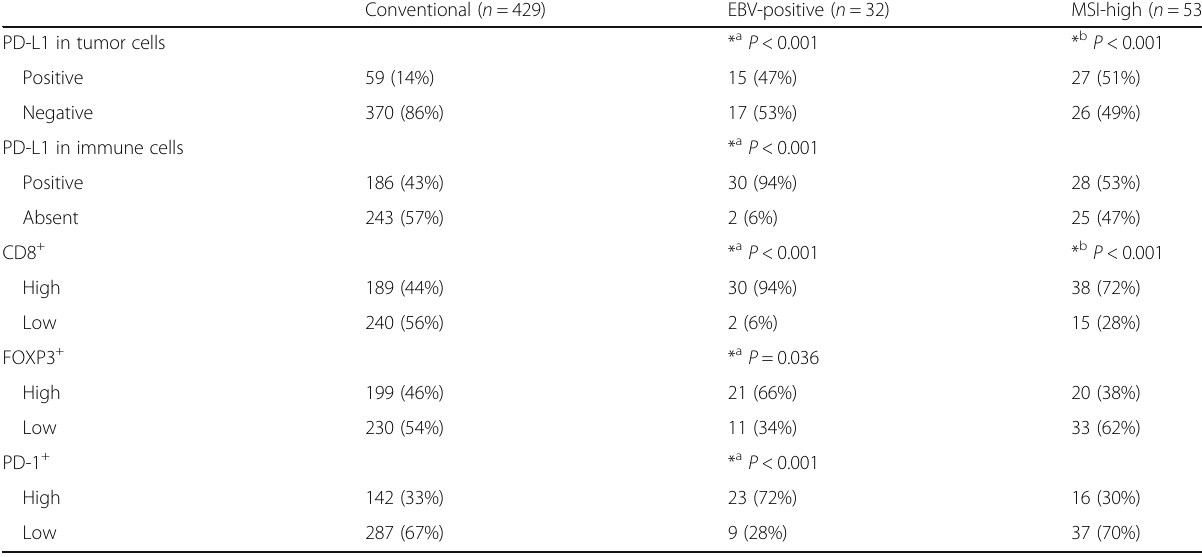
Table 3 Comparison of PD-L1 Expression and Tumor-Infiltrating Lymphocytes in Each Molecular Group